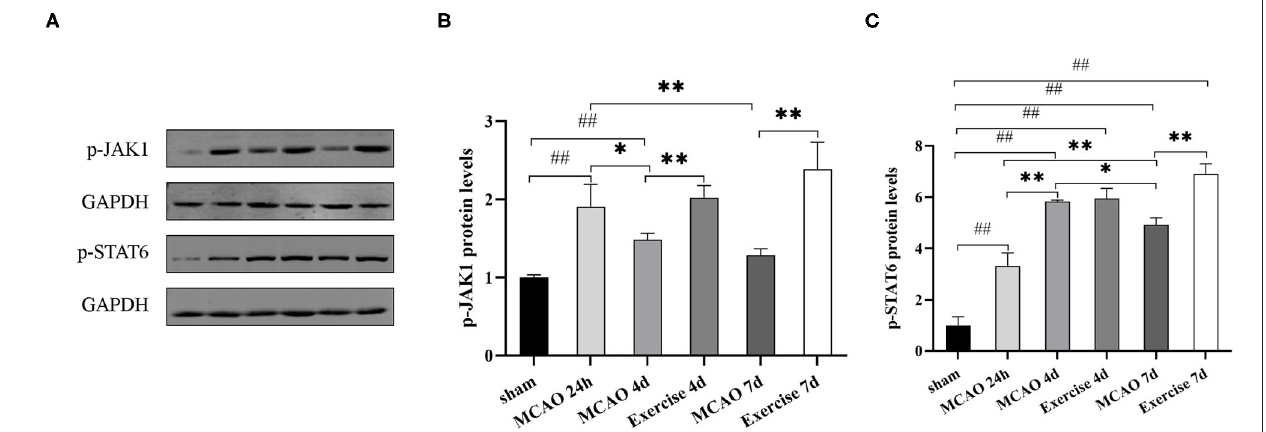
FIGURE 6 | Treadmill exercise regulated microglia polarization through the JAK1/STAT6 pathway after MCAO. (A) The representative protein band of p-JAK1 and p-STAT6 was acquired by western blotting with the protein GAPDH serving as the control. Relative protein level of p-JAK1 (B) and p-STAT6 (C) in the penumbra on the 1st, 4th, and 7th day among the sham, MCAO and exercise groups are shown. Data are presented as the mean ± SD, n = 3/group. ## P < 0.01 vs. sham group; * P < 0.05, ** P < 0.01 vs. MCAO